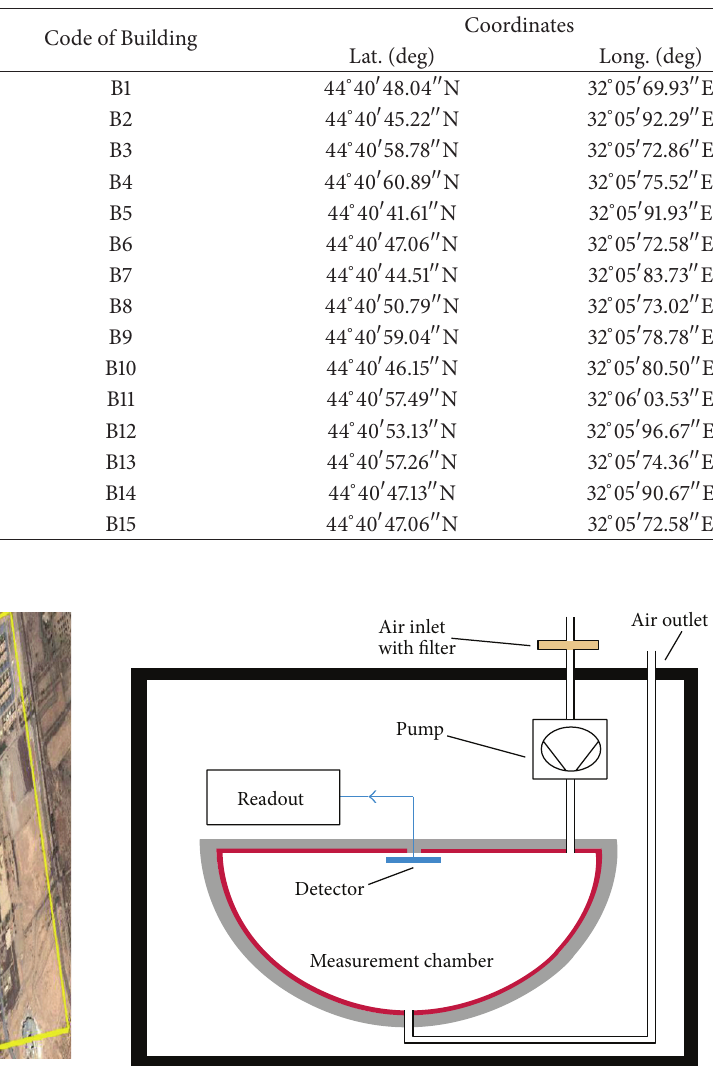
Table 1: Sites of measurements in studied area for taking samples.